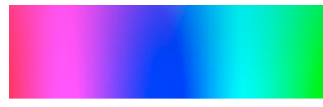
Figure 3. Color Figure 3. Color Spectrum.